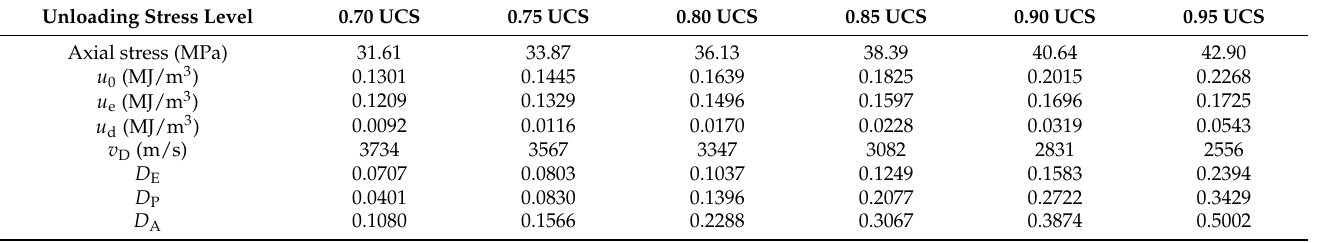
Table 1. Average values of different parameters obtained at complete pore water pressure dissipation.